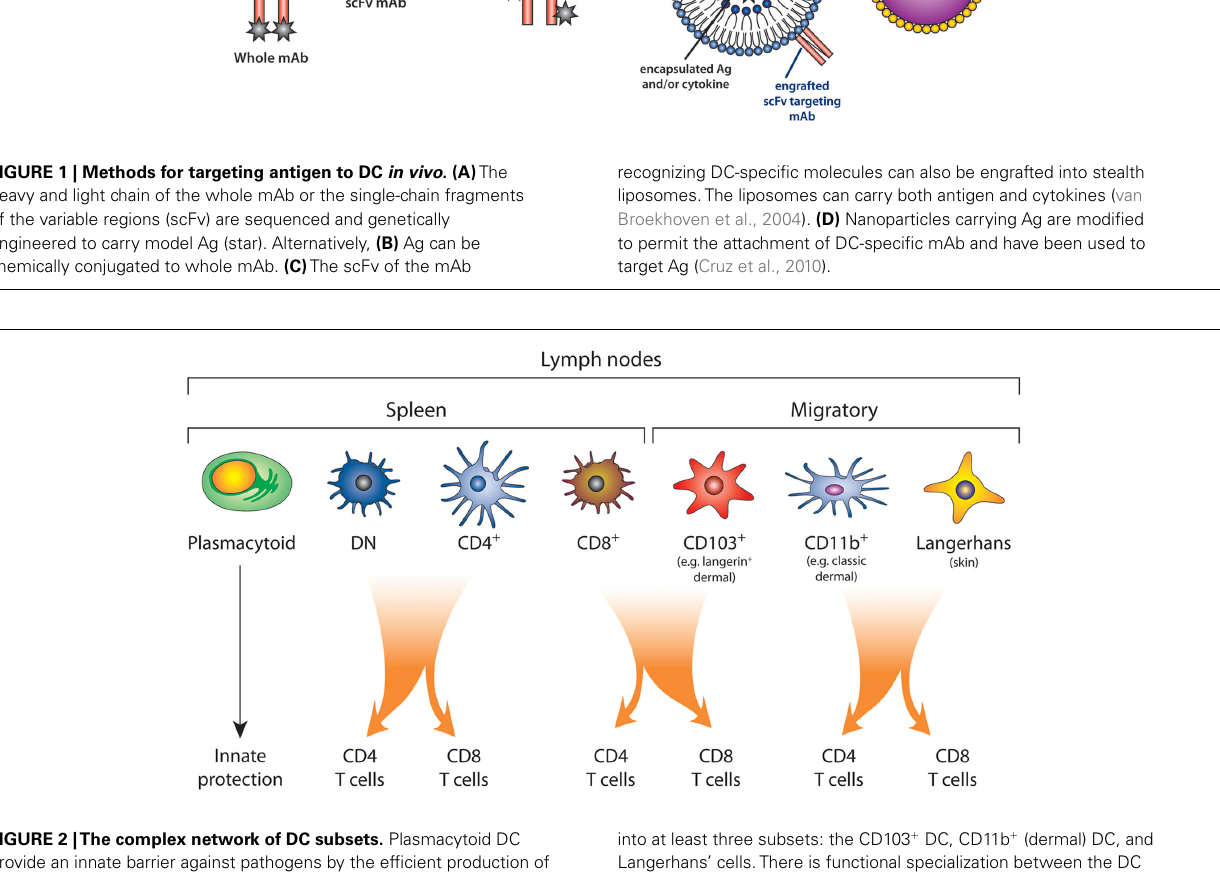
into at least three subsets: the CD103 + DC, CD11b + (dermal) DC, and Langerhans’ cells.There is functional specialization between the DC subsets, where the CD103 + DC and CD8 + DC are most proficient at cross-presentation and activation of CD8 + T cells. By contrast, splenic DN and CD4 + DC and lymphoid CD11b + DC and Langerhans’ cells are more efficient at driving CD4 + T cell responses. Although, under certain conditions both CD4 + DC, DN DC, and Langerhans’ cells have been shown to cross present antigen (Pooley et al., 2001; Flacher et al.,